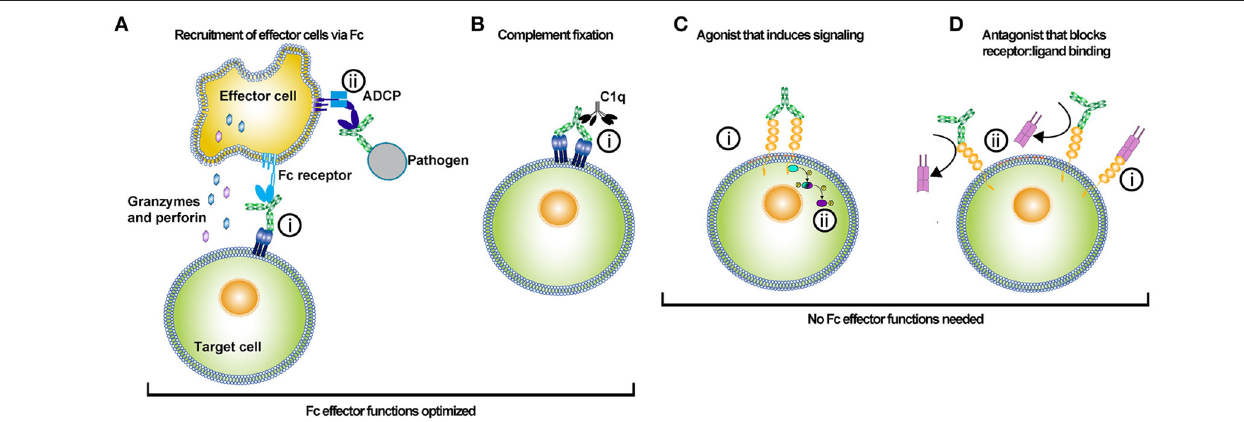
FIGURE 1 | Uses of antibody-based biologics. The type of Fc optimization undertaken for an antibody depends on the desired function of the antibody in vivo . Antibody-based biologics are principally used as adaptor molecules for effector cell recruitment to targets, inducers of the classical complement pathway, agonists, or antagonists. (A) Antibody biologics can be used to opsonize target cells or pathogens and recruit effector cells to kill or phagocytose the target cell or pathogen. (i) Antibodies bind to the antigen via their Fabs and recruit effector cells via their Fc interacting with Fc receptors. Recruitment of the effector cell to the target cell and release of cytotoxic molecules, such as granzyme and perforin results in target cell killing. Alternatively, (ii) effector cells can bind to the Fc of an antibody that has opsonized a pathogen, and subsequently phagocytose the pathogen via antibody-dependent cellular phagocytosis (ADCP). Much of the Fc engineering effort has been focused on improving Fc affinity for various activating Fc γ Rs. The improvement of Fc affinity for Fc γ Rs has led to augmented ADCC and ADCP activity for the optimized antibody-based biologic. (B) Antibodies can kill target cells through the initiation of the complement pathway. The initial step in initiating the complement pathway is the binding of complement protein 1q (C1q). (i) C1q binds to the Fc of antibodies in complex with antigen. Specific mutations have been introduced into the Fc of antibodies to enhance Fc binding affinity to C1q. (C) Agonistic antibody-based molecules are designed to bind to ligand and induce signaling by crosslinking a membrane-bound receptor. (i) Binding of both Fab arms crosslinks the cell receptor and (ii) subsequent phosphorylation of intracellular signal transducers potentiates the receptor signaling. These types of antibody-based biologics do not require Fc function; hence these molecules are prime candidates for Fc optimization that silences Fc γ R and complement binding. (D) Antagonistic antibody-based biologics bind to a target molecule and prevent the function of that protein either directly or by blocking its ligand from binding. (i) Typically the ligand binds to its receptor, (ii) but in the presence of the antagonistic antibody the receptor binding site is competitively or allosterically blocked. The lack of ligand binding prevents intracellular signaling by the membrane-bound receptor. In this instance, Fc effector functions are not needed and thus mutations that silence Fc effector function can be employed to optimize these types of biologics.